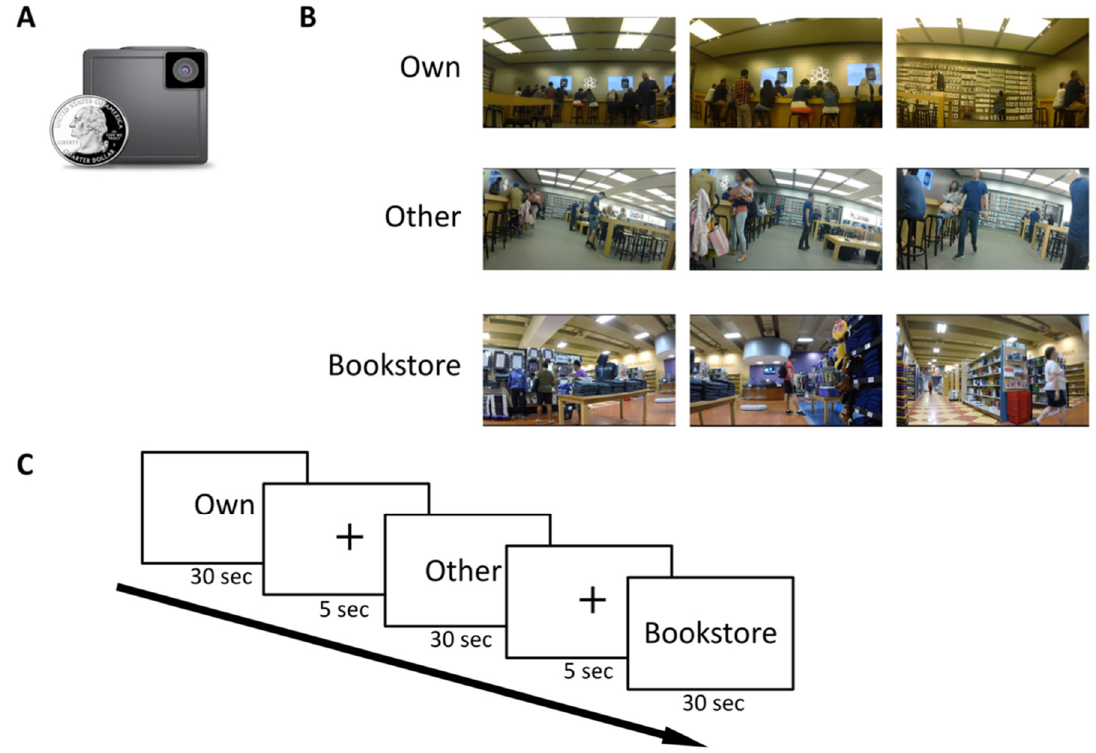
Figure 1. Experimental design. ( A ) The small wearable camera used in the study (iON SnapCam LE). ( B ) Participants viewed short video clips (30 sec long) in the scanner, that belonged to one of three different categories: Own videos (autobiographical videos, taken from their own experiences at the mall a week prior to scanning), Other videos (experiences of other participants in the study, recorded at the same location), and Bookstore videos (recordings of other people’s experiences in a different location altogether). ( C ) Video clips were presented in a random order, with a five second ITI. Each scanning run comprised 16 videos. There were six runs in total. Each participant viewed 96 clips in total (48 clips each repeated once).